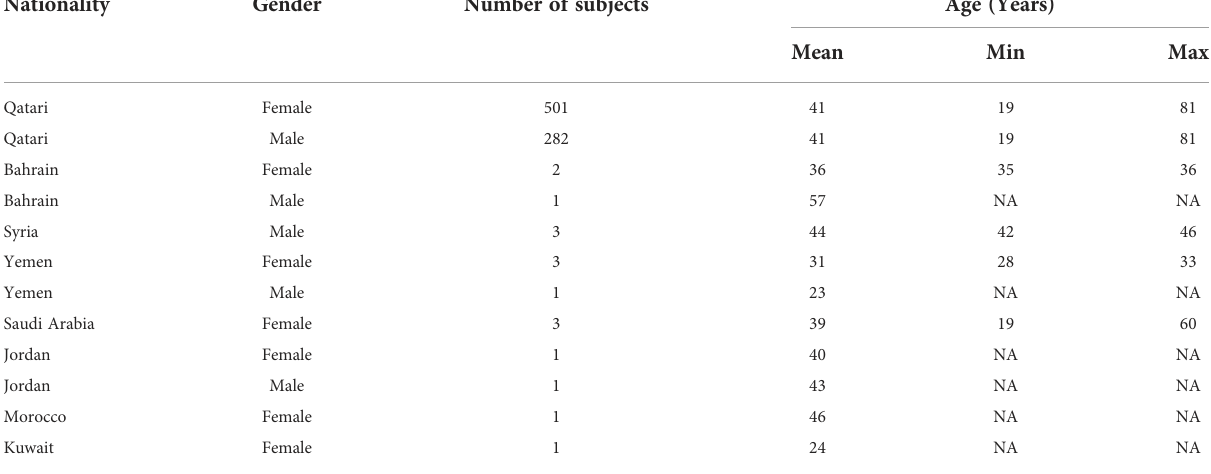
TABLE 1 Demographic information of the study